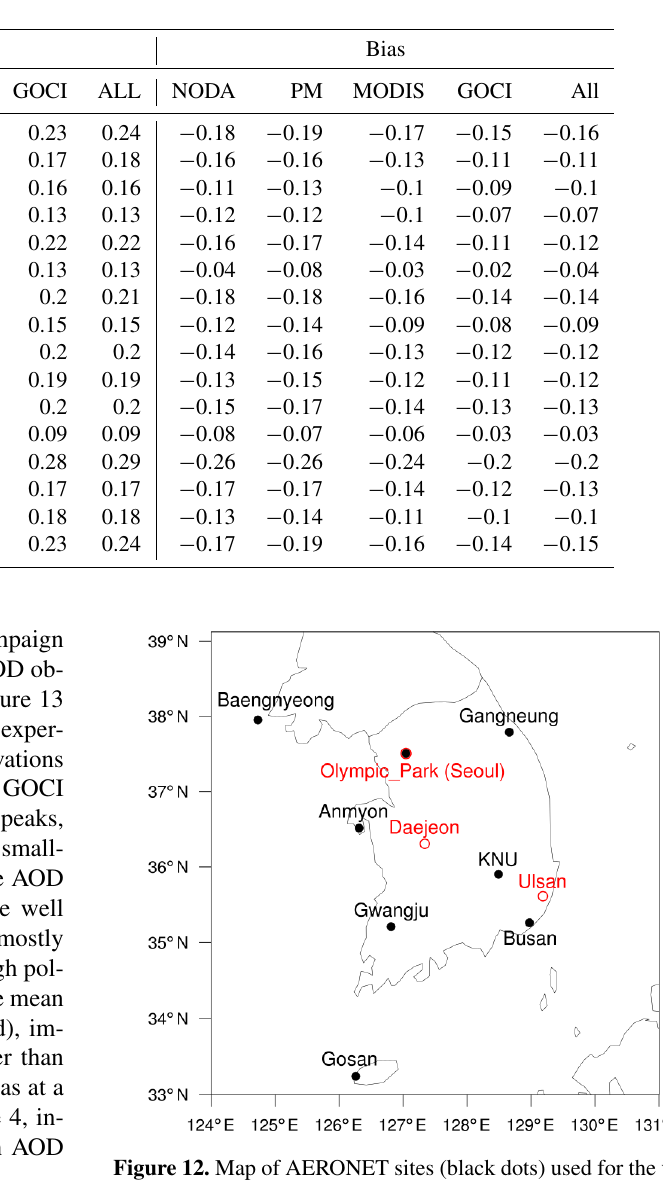
Table 4. Forecast error in total AOD at 500nm verified against AERONET sites, computed over 0–23h forecasts from the 00:00UTC analysis for 4–31 May.